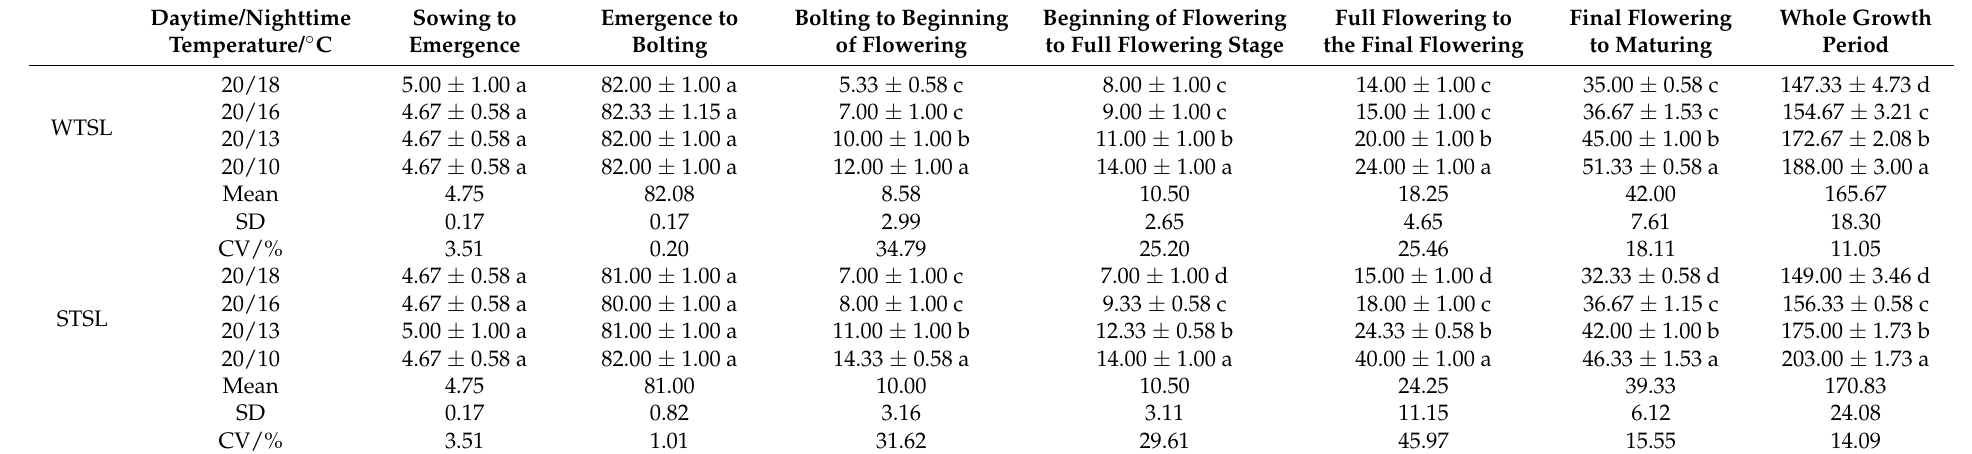
Table 1. Effects of development period at different nighttime